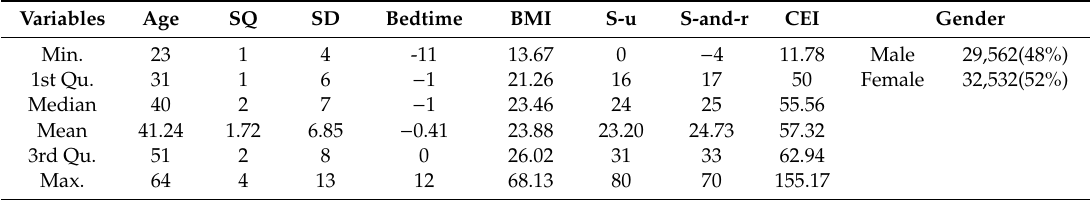
Table 1. Statistical